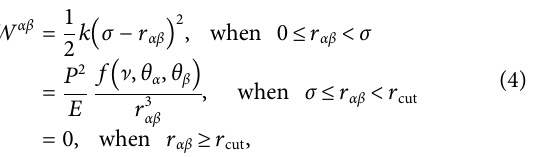
Frontiers in Physics |